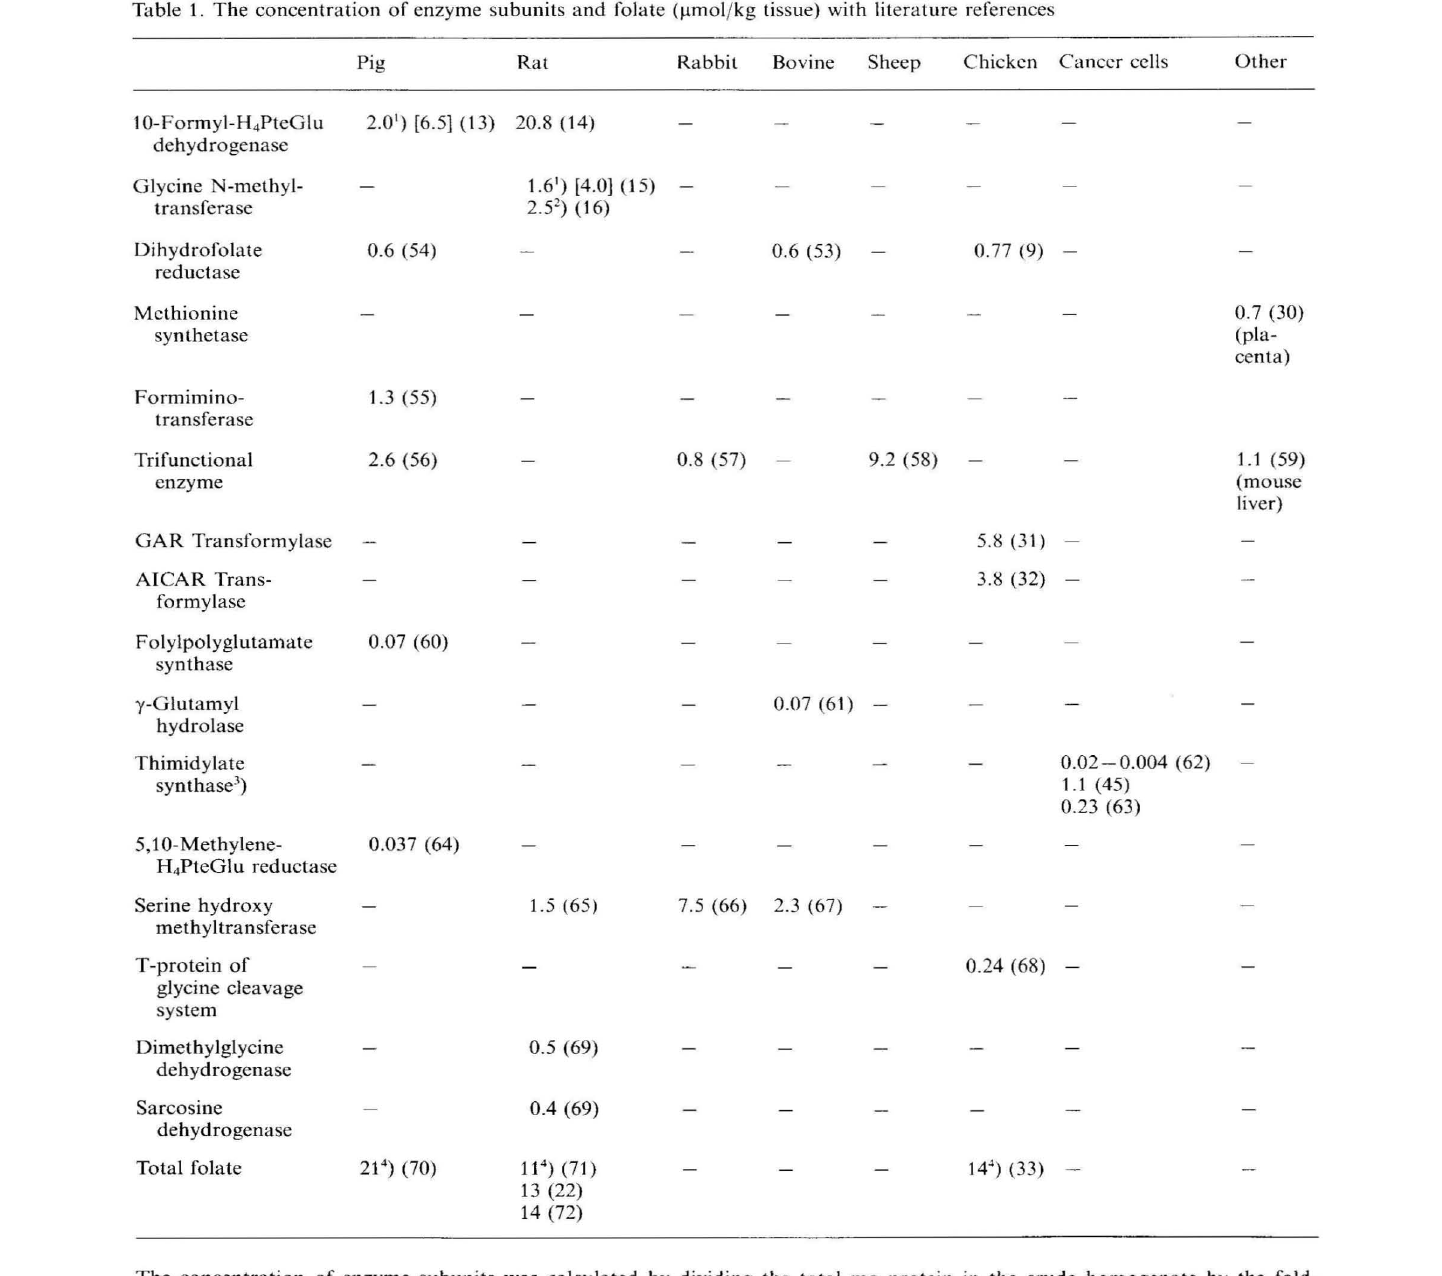
10-Formyl-H4PteGlu